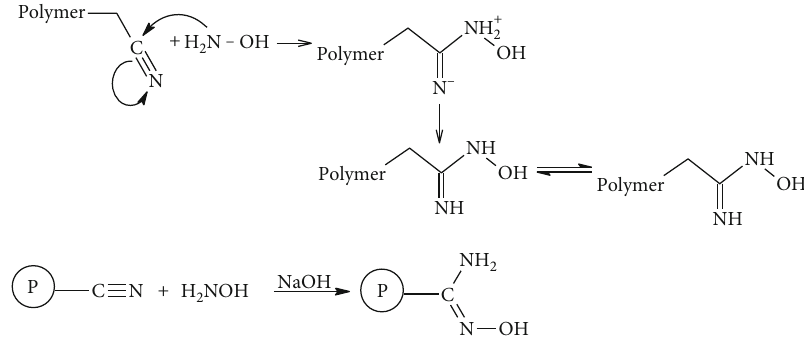
Figure 7: Reaction mechanism of preparation of polyamidoxime resin.